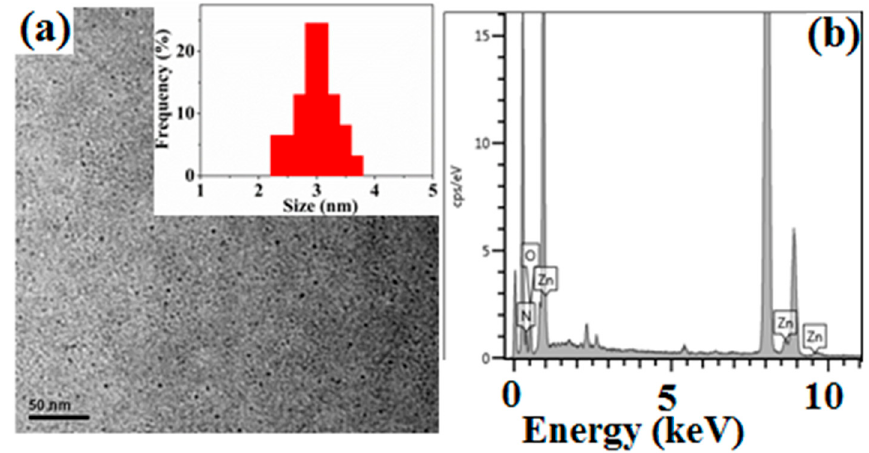
Figure 3. Transmission electron microscopy (TEM) image ( a ) and energy-dispersive X-ray spectrometer (EDS) spectrum ( b ) of ZnO QDs synthesized under a [Zn 2+ ]/[OH − ] molar ratio of 1:2 and 10 h heating. The scale bar is 50 nm. The inset shows the size distribution of ZnO QDs.